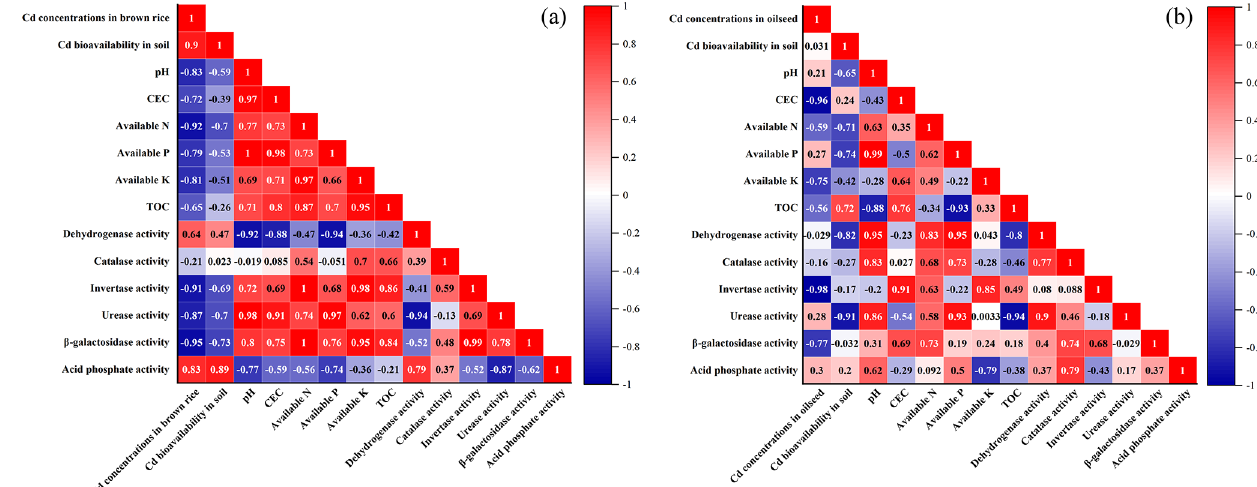
Figure 7. The correlation of investigated parameters in rice planting (a) and rice–oilseed planting (b)